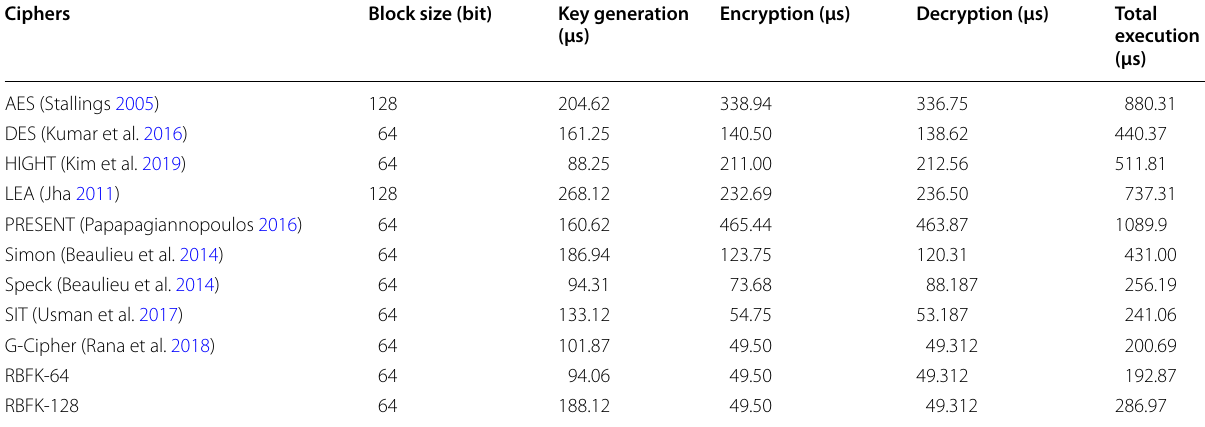
Table 5 Time complexity of proposed RBFK ciphers, as well as others, for a single block of plaintext on an AVR architecture-based microcontroller, notably